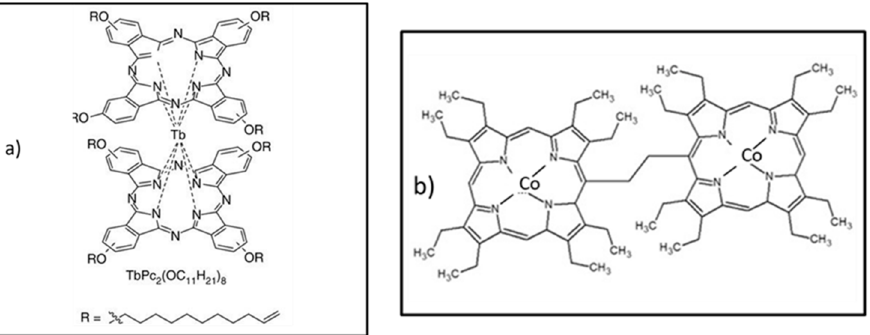
Figure 1. Molecular structures of ( a ) TbPc 2 (OC 11 H 21 ) 8 terbium phthalocyanine derivative and ( b ) bis porphyrin derivative CoCoPo 2 used as active molecules.